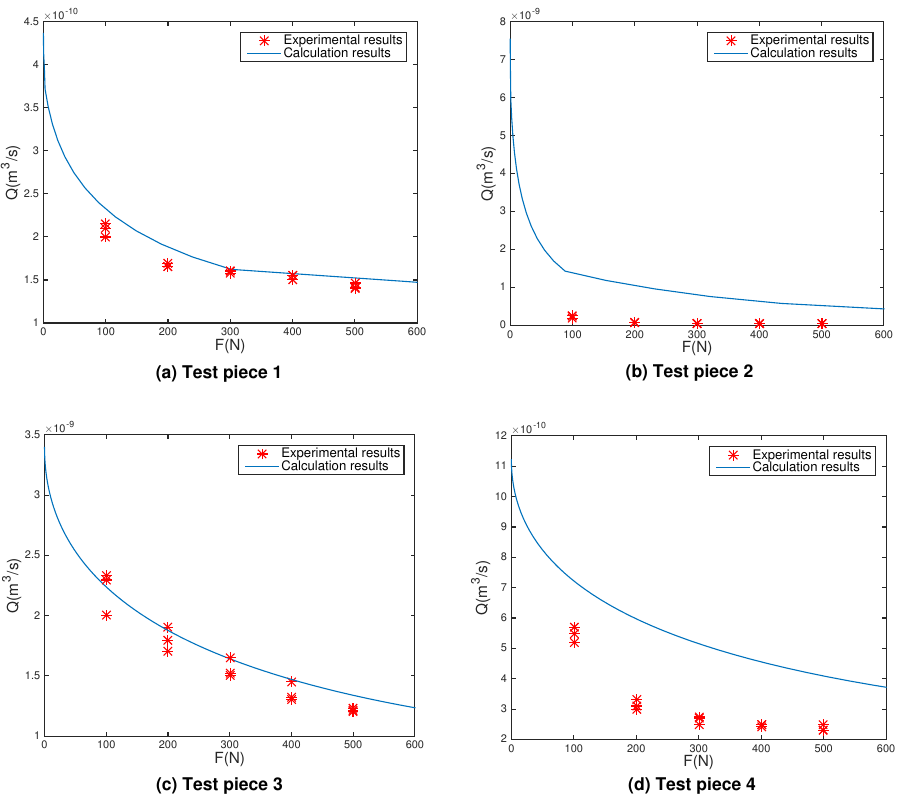
Figure 6. The leak rate versus the contact load through the four test pieces: ( a ) Test piece 1; ( b ) Test piece 2; ( c ) Test piece 3; and ( d ) Test piece